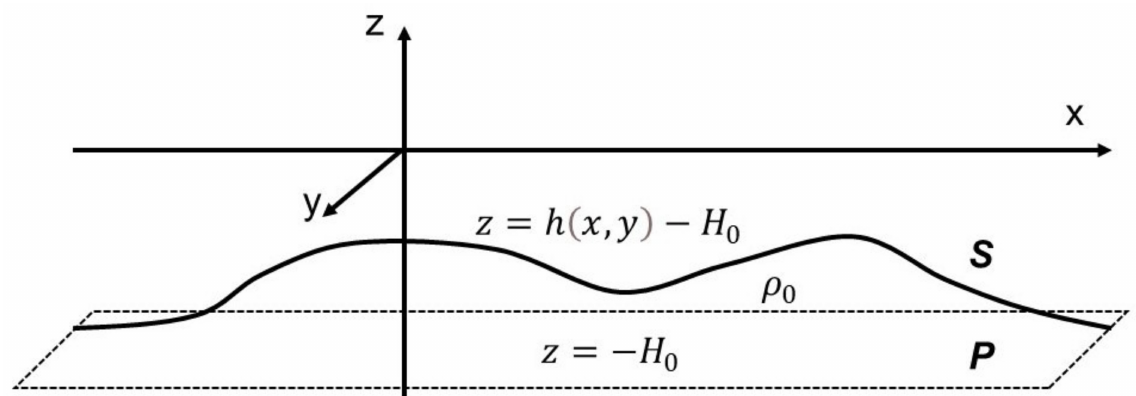
Figure 1. Sketch of a model of the sediment-to-basement interface. Cauchy-type integral, C S density contrast surface, S